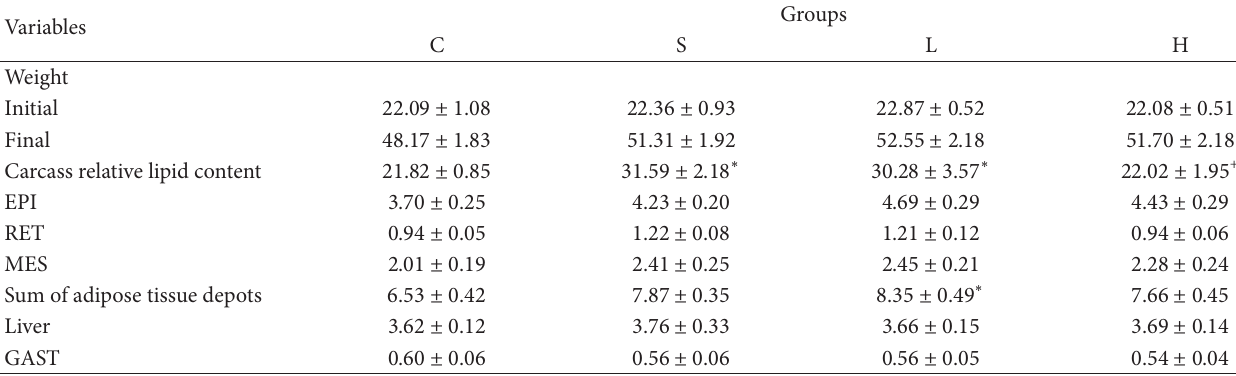
Table 3: Body Mass (g), carcass relative lipid content (g/100g), sum of adipose tissue depots (g/100g) and tissue weight (g/100g) of studied mice groups-(C) control group, (S) Soybean, (L) Lard and (H) Hydrogenated vegetable fat groups.